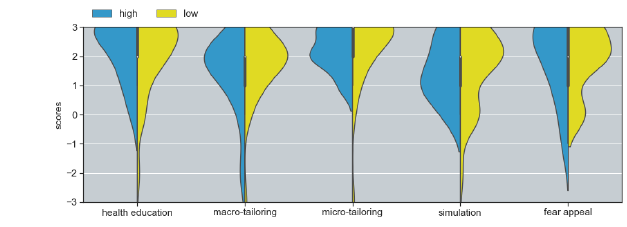
Figure 2. Motivational design techniques regarding